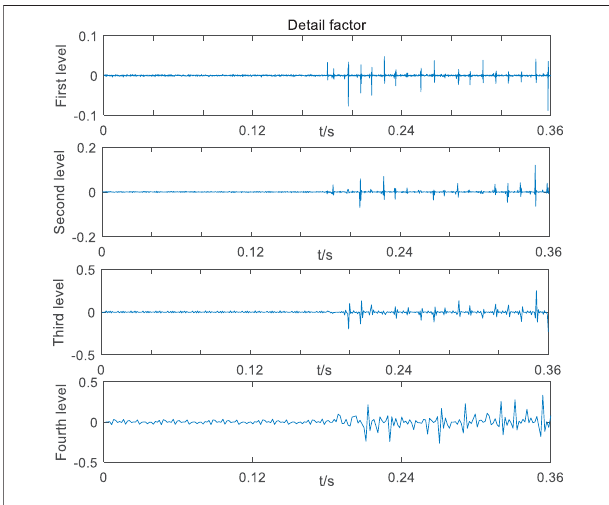
FIGURE 7 | Wavelet transform detail components.